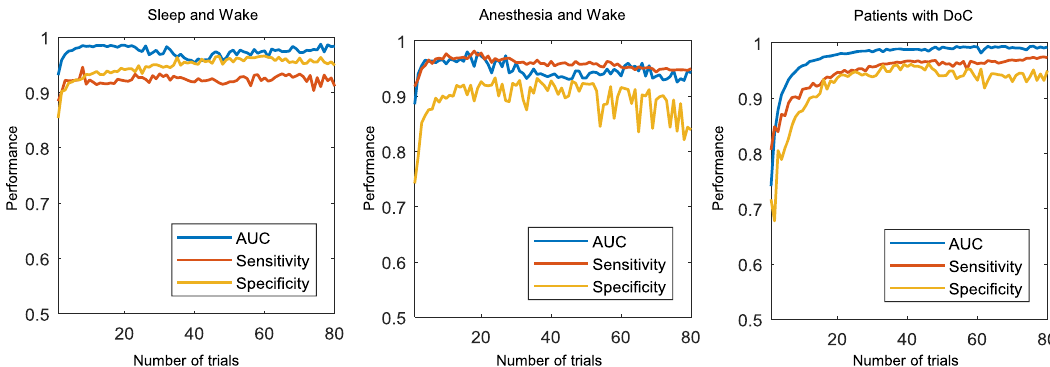
Fig. 5 Performance of ECI awa according to the number of trials in the ECI calculation. During sleep and healthy wakefulness (left), under anesthesia and wakefulness before anesthesia (middle), and in severely brain-injured patients (right). The area under the curve, sensitivity, and speci fi city were measured for calculating ECI awa when going from single trials to 80